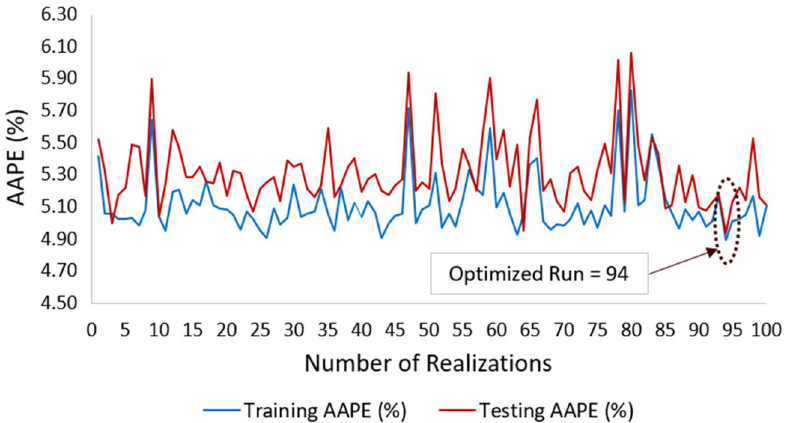
Figure 8. Testing and training AAPE at optimized neurons for 100